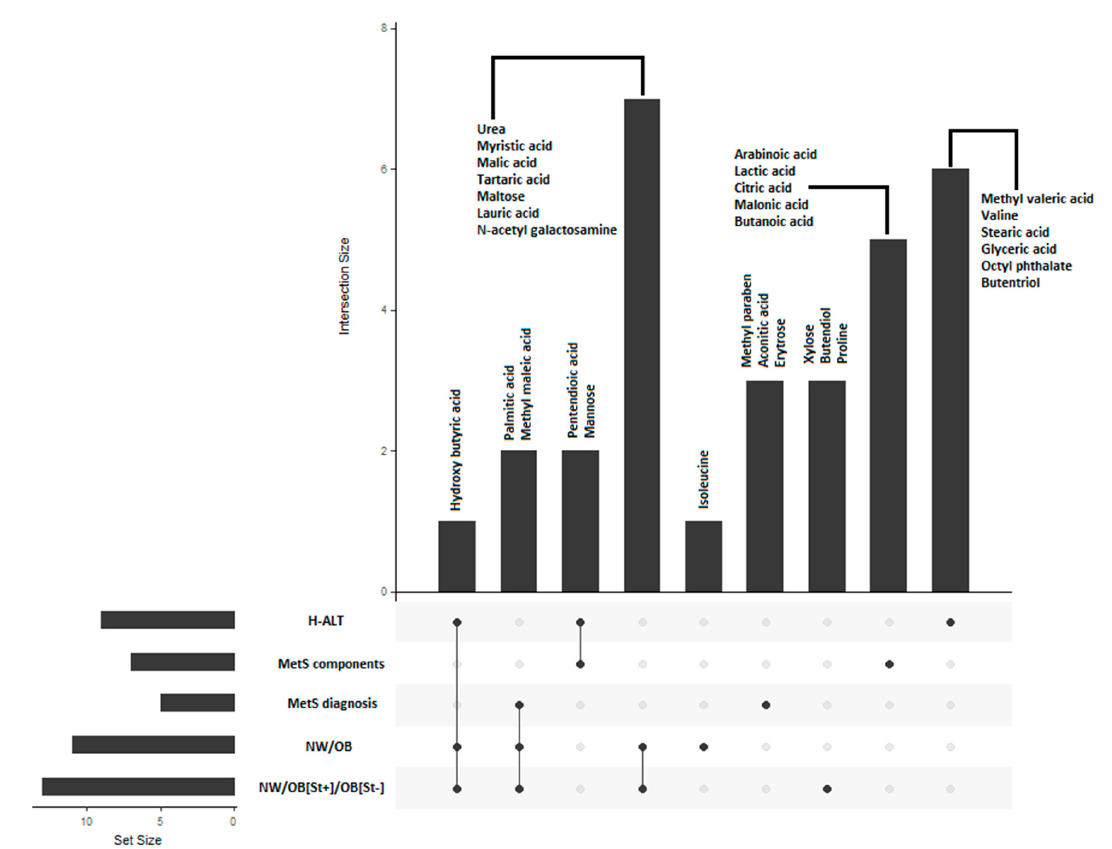
Figure 4. UpSet representation of the metabolites selected in the different classification models. H-ALT: Hypertransaminasemia; MetS: Metabolic Syndrome; NW: normal weight, OB: obese, [St]: hepatic steatosis.